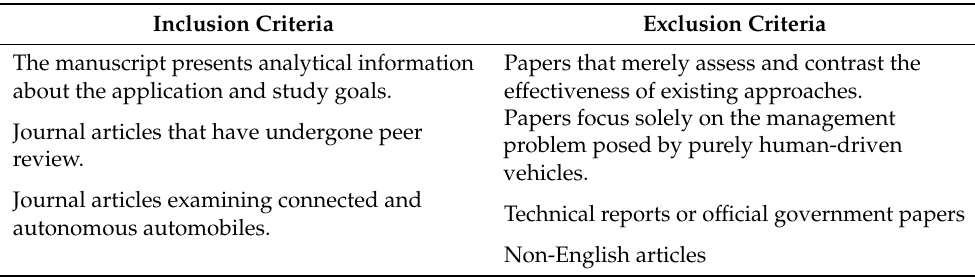
Table 3. Inclusion/exclusion